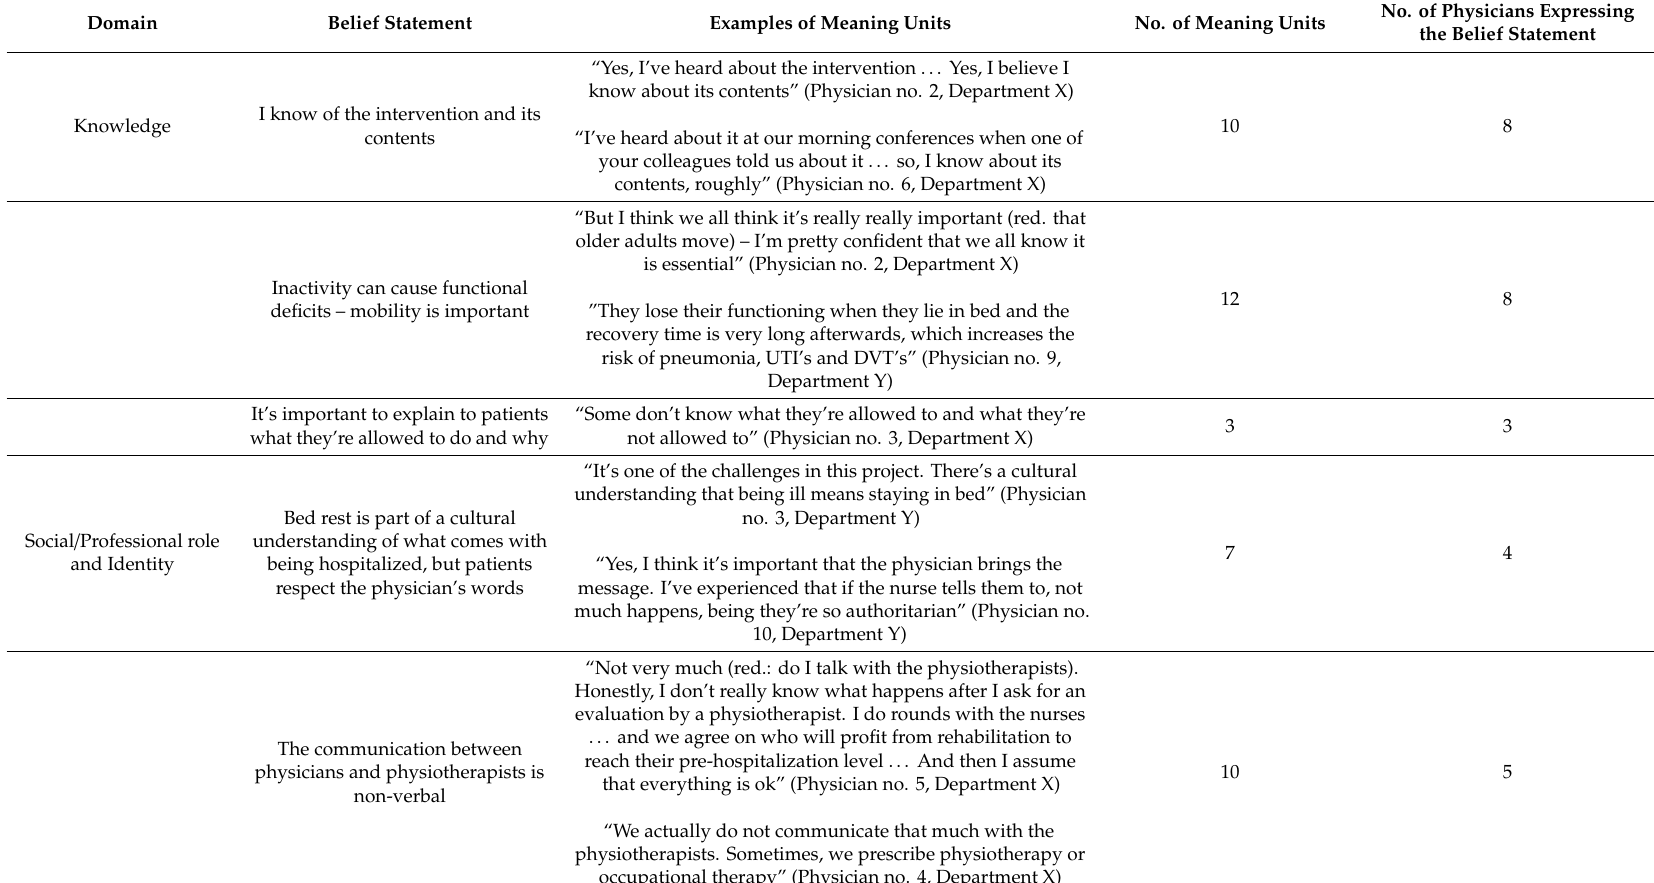
Table 3. Belief statements within the 5 domains identified as being of high importance (i.e., reflecting 5% or more of the meaning units) and examples of meaning units.